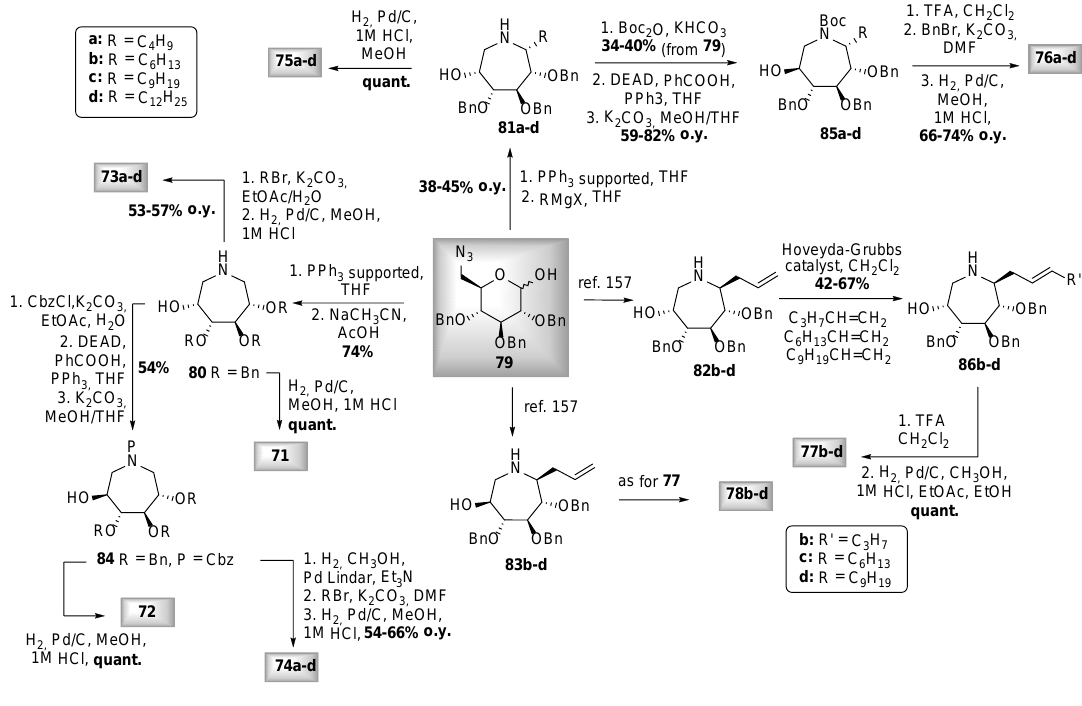
Figure 16. Azepane iminosugars as F508del-CFTR correctors. ** p < 0.01; *** p < 0.001; ns, not significant. This figure is republished with permission of the Royal Society of Chemistry, from [156]; permission conveyed through Copyright Clearance Center, Inc. The mechanism behind the observed activity was not clear; the authors hypothesized that a binding process to the glycosylated site of the protein could be involved [156].